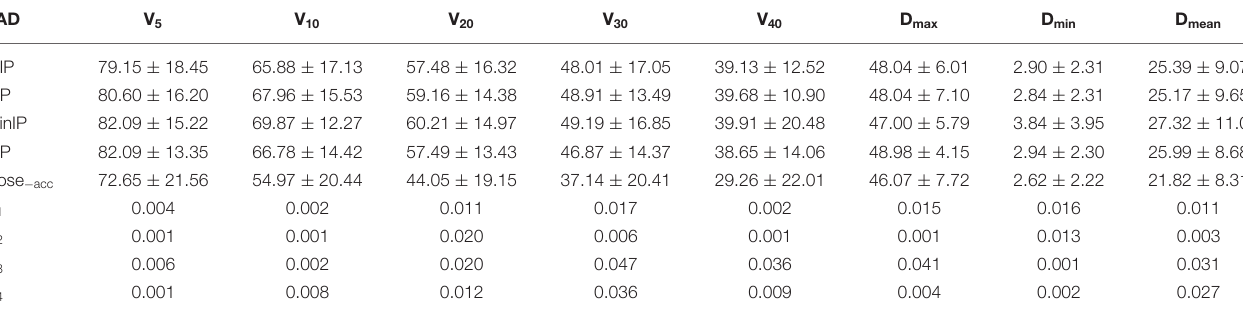
TABLE 3 | Dose-volume changes in the left anterior descending coronary artery ( x ± s)